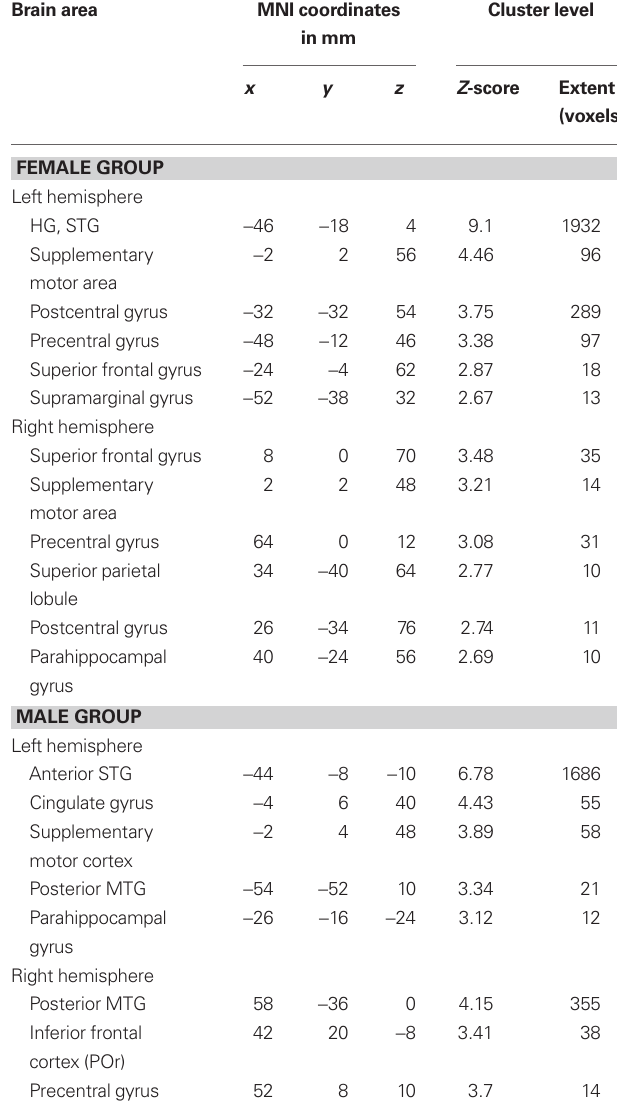
( Table 4 ). The interaction between score, orientation, fre- quency, and sex was not significant (repeated-measures ANOVA